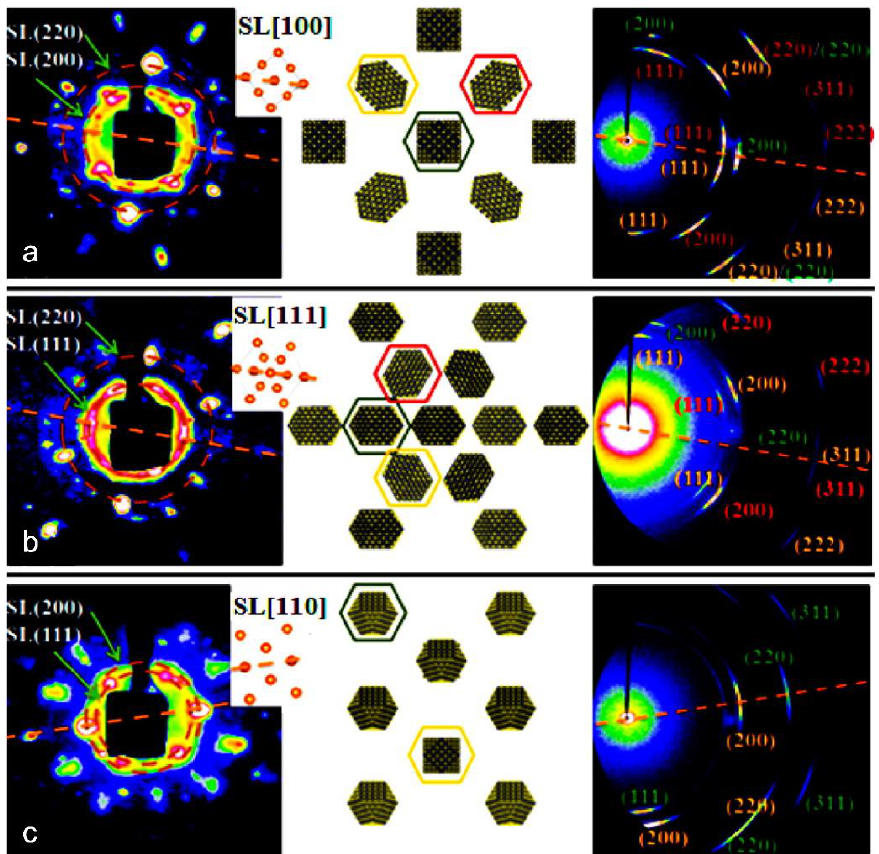
Figure 7. Structural reconstruction of truncate PbS NC assembled supercrystal as projected from SL [100] ( a ), SL [111] ( b ), and SL [110] ( c ) orientations, respectively. Three panels include: ( Left ) SAXS patterns with inset showing the superlattice projection; ( Middle ) structure and orientations of truncate NCs at typical crystallographic directions; and ( Right ) WAXS images with Miller indices. Note: (1) the dotted lines and circles guide comparison; (2) the various colors show di ff erently oriented NCs in superlattice that yield X-ray scattering spots as marked in the same colors. Copyright of the American Chemical Society